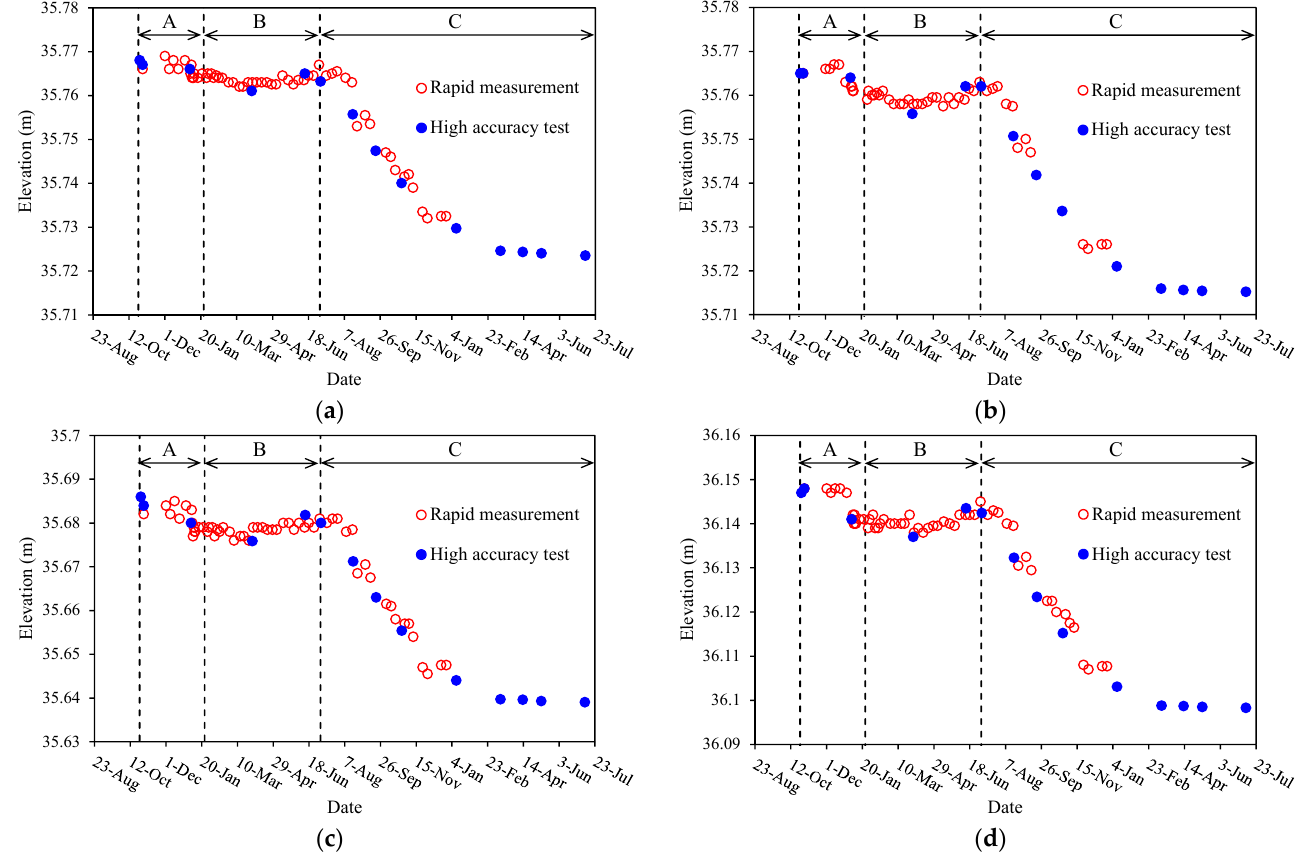
Figure 4. Settlement curve of each monitoring point at the shaft tower foundation in the process of drilling, frost heaving and thaw settlement (DHS process). ( a ) Monitoring point J1; ( b ) monitoring point J2; ( c ) monitoring point J3; ( d ) monitoring point J4.